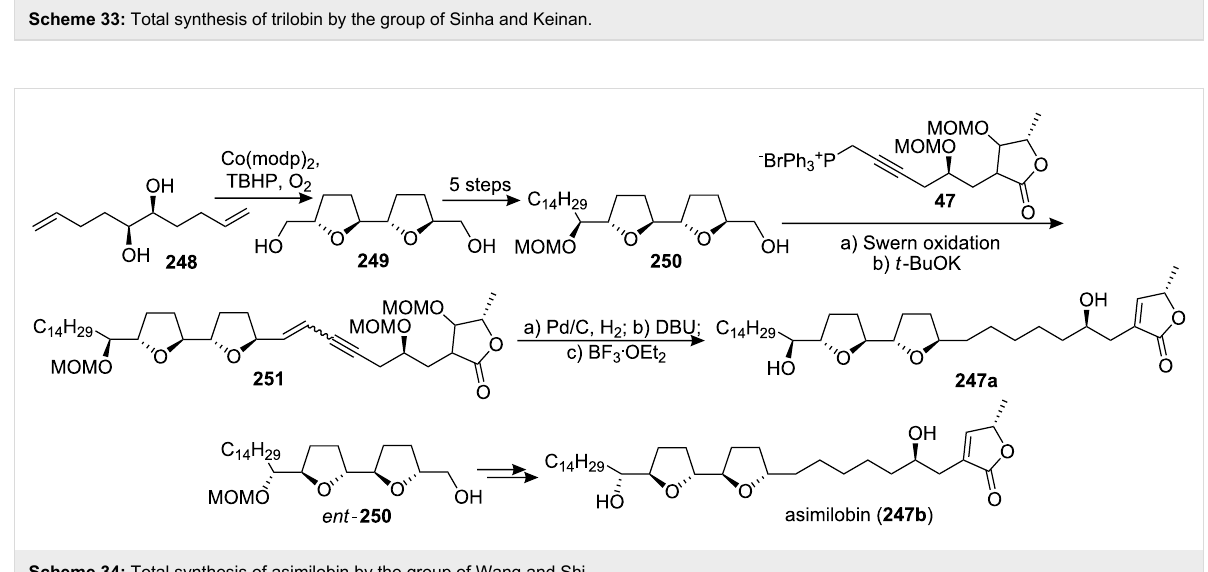
Scheme 34: Total synthesis of asimilobin by the group of Wang and